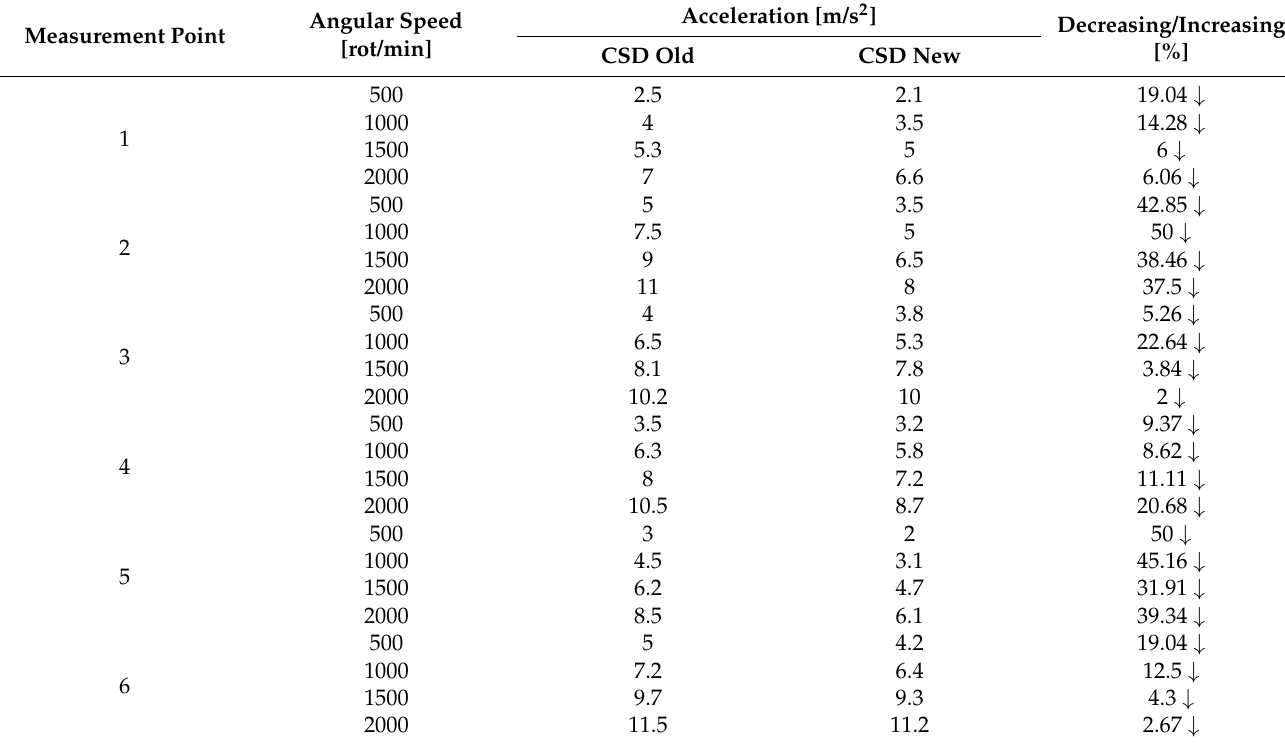
Table A1. The measured accelerations on six points of the adder gearbox. Measurement Point